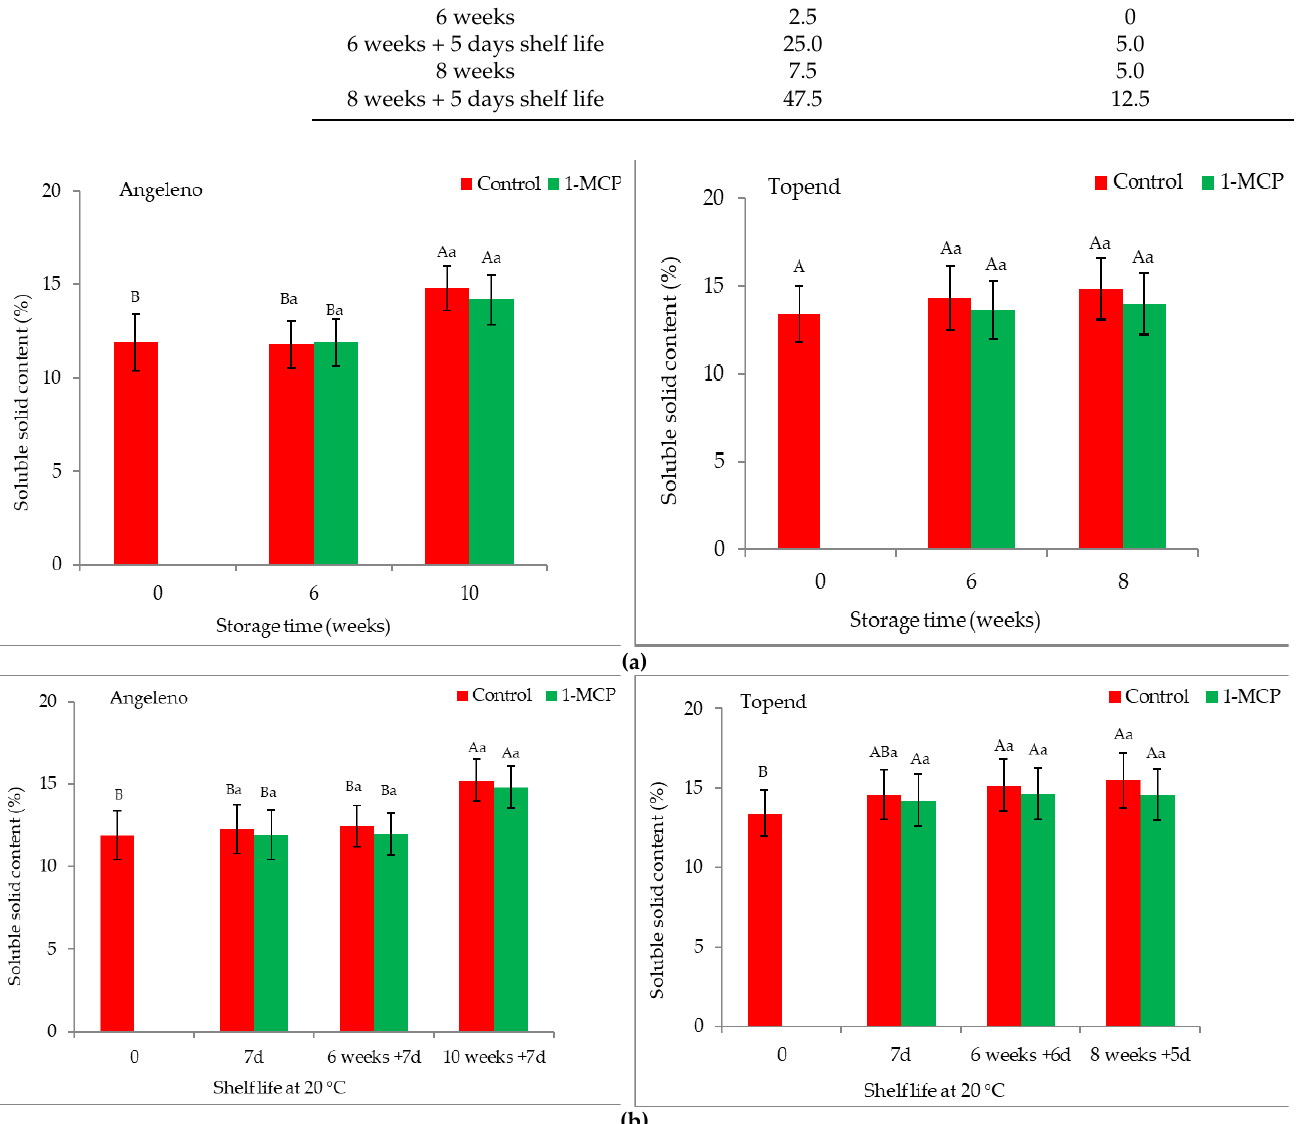
Figure 5. Soluble solid content of plum during cold storage at 1 °C ( a ) and subsequent shelf-life storage at 20 °C ( b ). Presented values are mean ± SD. Upper case is for the comparisons of time (Tukey’s, p < 0.05). Lower case is for the comparisons of treatment (Tukey’s, p <